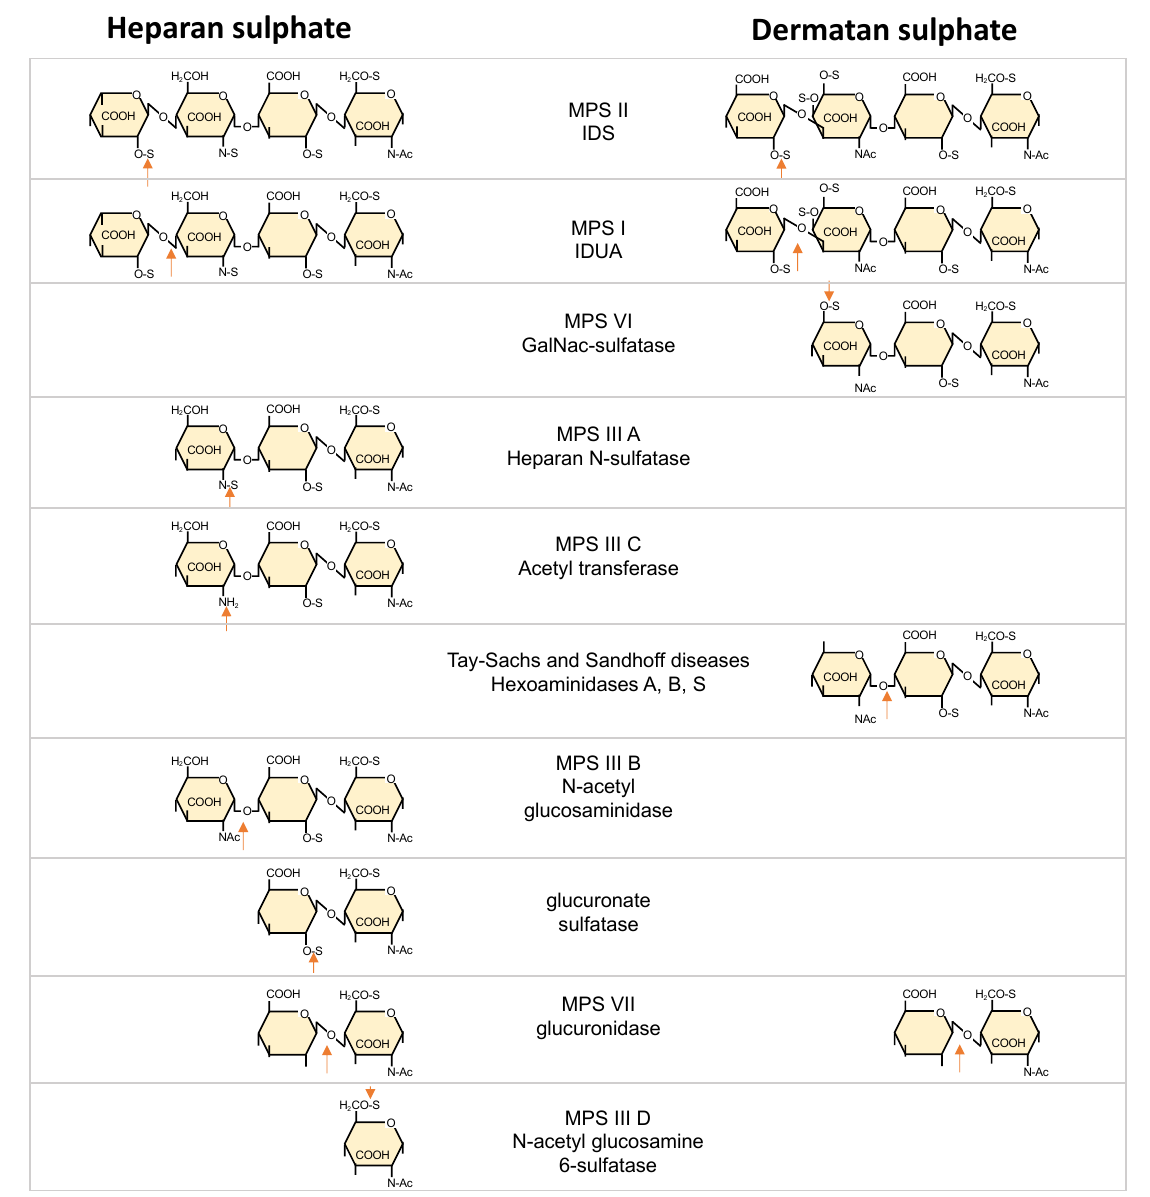
Figure 1. GAG catabolism begins with endohydrolysis of the polysaccharide chains to oligosaccharides. After this initial step, HS and DS oligosaccharides are degraded from their nonreducing ends (NRE) to monosaccharides and inorganic sulfate. The enzymes involved in the first two steps are IDS, which hydrolyzes the C2-sulfate ester bond of nonreducing terminal alpha-L-Iduronic acid (IdoA) residues in HS and DS and IDUA, which removes non-sulfated terminal alpha-L-IdoA residues. Under normal conditions, HS degradation produces IdoA and glucuronic acids (GlcA), while DS degradation results in IdoA and N-acetyl galactosamines (GalNAc). Defects in IDS activity result in accumulation of oligosaccharides with sulfated IdoA units on their NRE, while defects in IDUA activity result in oligosaccharides with non-sulfated IdoA units at their NRE